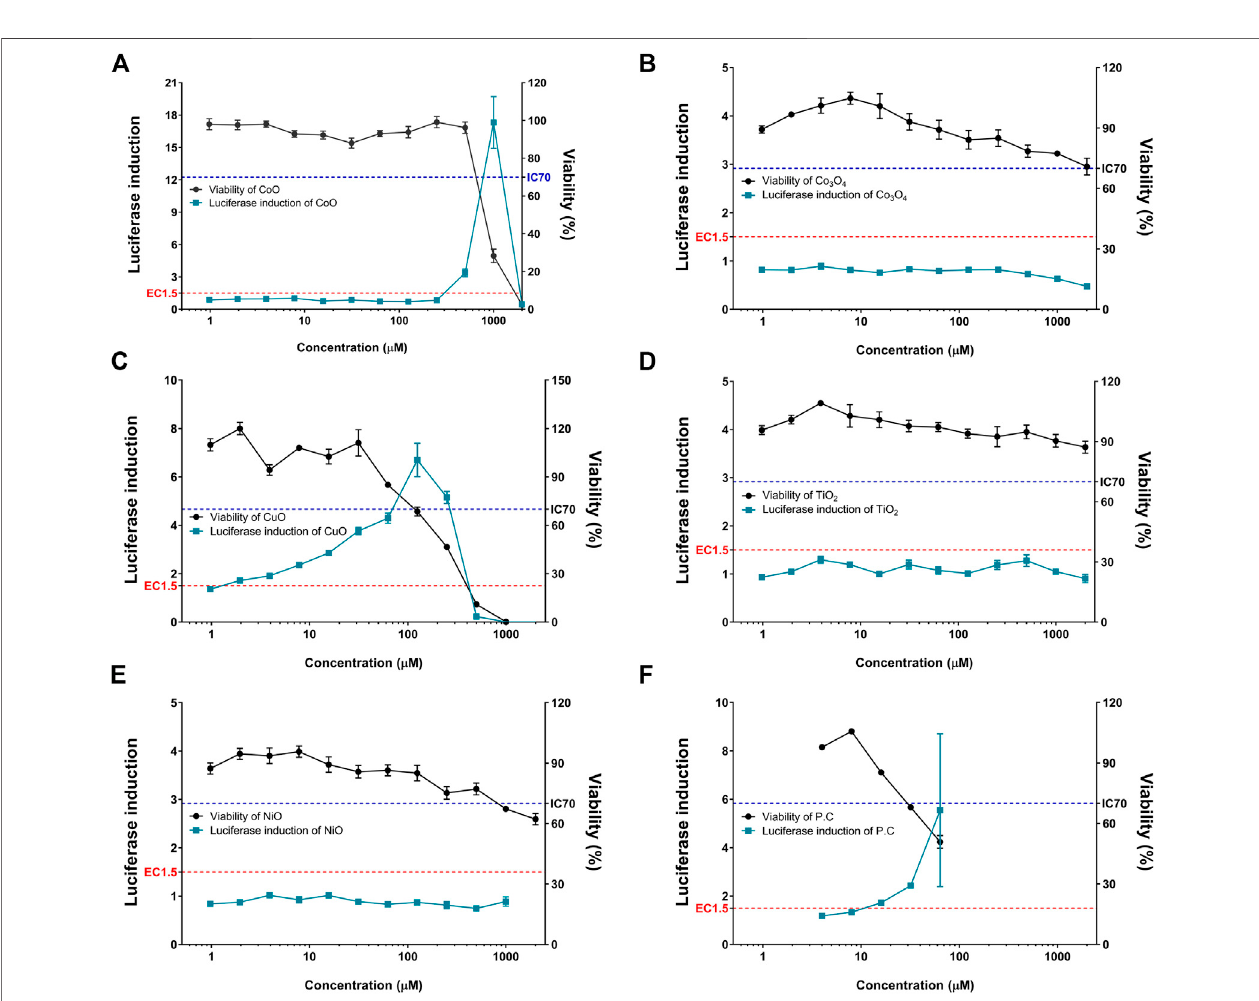
FIGURE 2 | Induction of luciferase activity (green squares) and cell viability (black rounds) in the KeratinoSens TM assay. KeratinoSens TM cells were treated with fi ve metal oxide NPs: (A) CoO, (B) Co 3 O 4 , (C) CuO, (D) NiO, and (E) TiO 2 NPs. (F) Positive control (cinnamic aldehyde, 4 – 64 µM) was tested in parallel. Data are expressed as mean ± standard deviation values (n (cid:2)